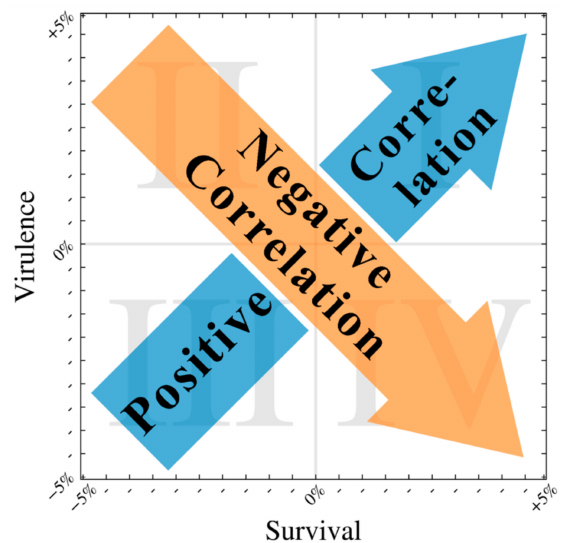
Figure 5. The expected e ff ect of increasing survival on virulence for the two correlation models considered: here, we present a schematic of how the di ff erent hypotheses for the relationship between virulence and survival manifest on a map with a structure similar to the heat maps shown in Figure 4. The directions of the arrows depict how increasing survival would a ff ect virulence under the two hypotheses: the blue arrow indicates the flow of an increasing positive correlation dynamic, while the direction of the orange arrow indicates an increasing negative correlation dynamic.